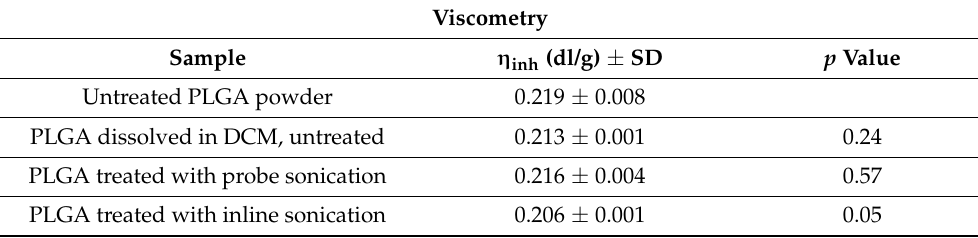
Table 7. η inh of the PLGA polymer treated and untreated via ultrasound. Significance of the difference ( p < 0.05) among the compared groups was determined with regards to the unprocessed PLGA